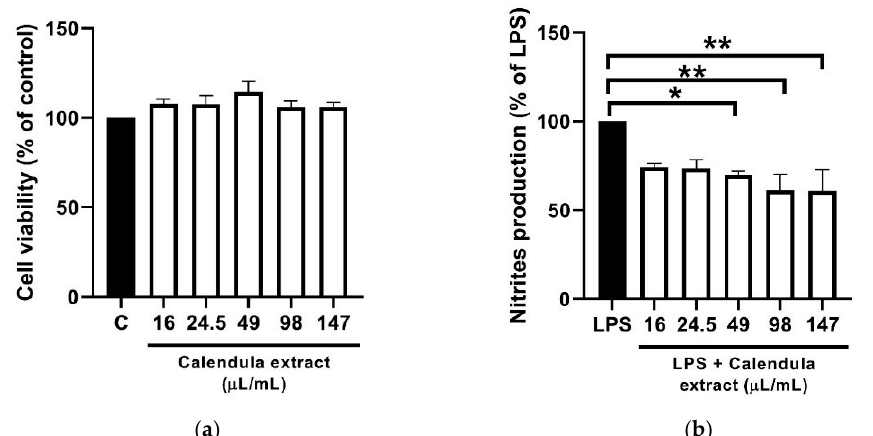
Figure 1. ( a ) Effect of Calendula oil on macrophages viability. The assessment of metabolically active cells was performed using a resazurin bioassay. The results are expressed as a percentage of resazurin reduction relatively to control cells. Each value represents the mean ± SEM from three independent experiments. ( b ) Effect of Calendula oil on NO production. Anti-inflammatory activity was measured as inhibition of nitrite production, quantified by the Griess assay. The results are expressed as a percentage of nitrite production relatively to LPS. Each value represents the mean ± SEM from three independent experiments. * p < 0.05, ** p < 0.01.